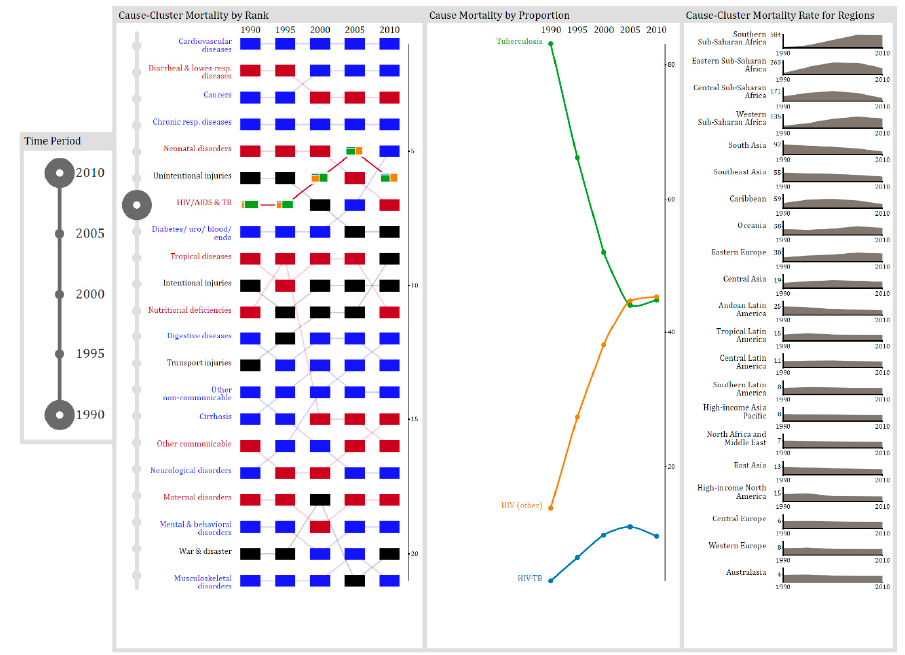
Figure 11. Chronology visualization with HIV/AIDS & TB cluster selected.